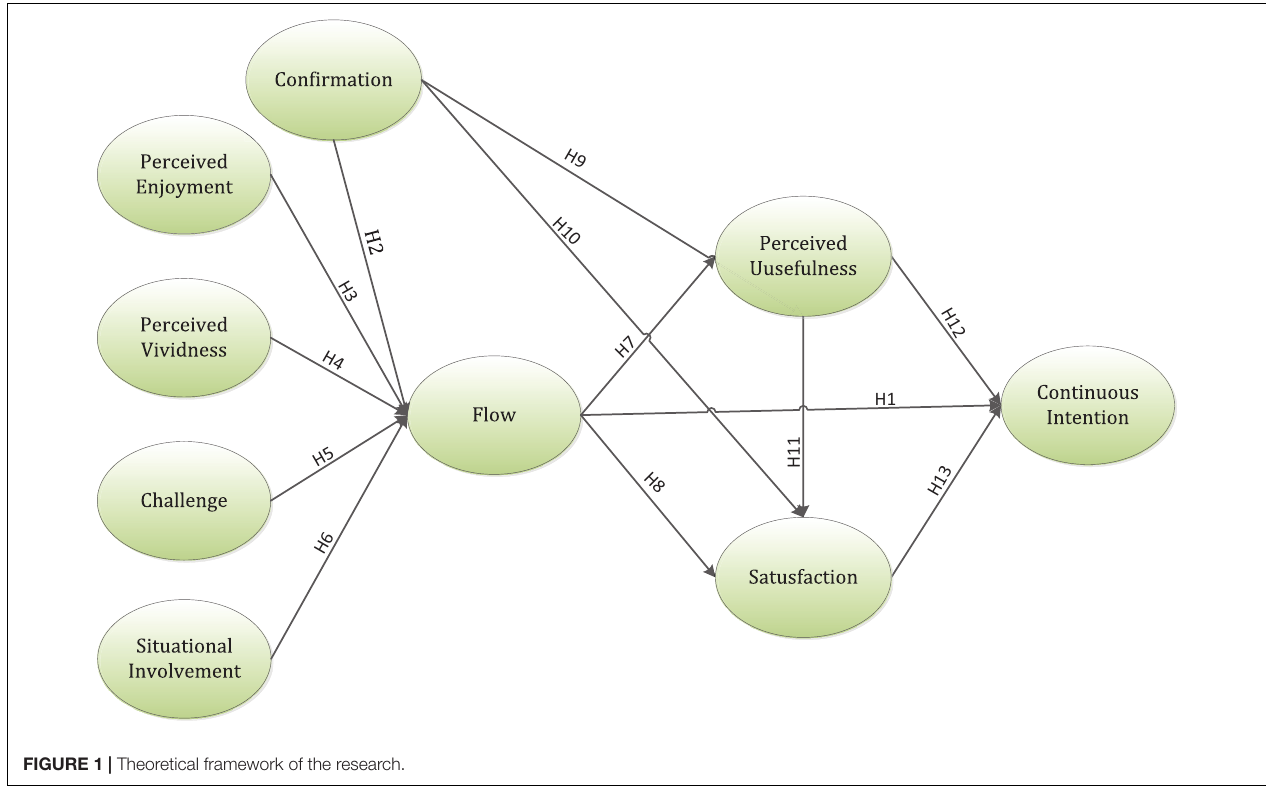
FIGURE 1 | Theoretical framework of the research.